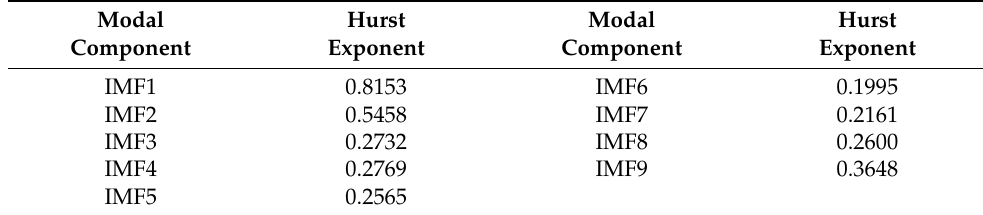
Figure 9. Hurst exponent diagram for intrinsic mode function. Table 2. IMF-H exponent numerical value of the vibration signal.